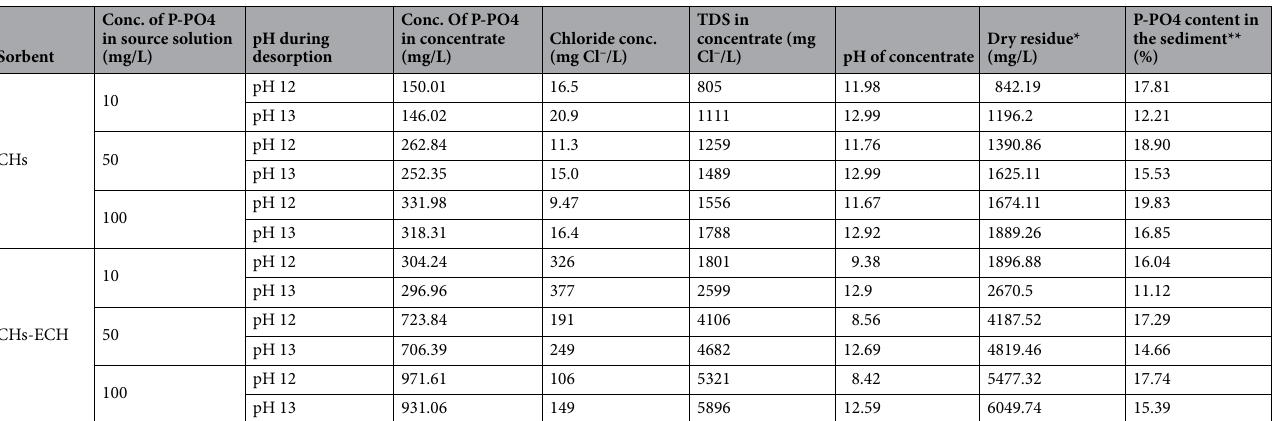
Table 2. Parameters of orthophosphate concentrate in the last sorption/desorption cycle. *Dry residue (after concentrate evaporation). **P–PO 4 content in the sediment after evaporation of the concentrate (105